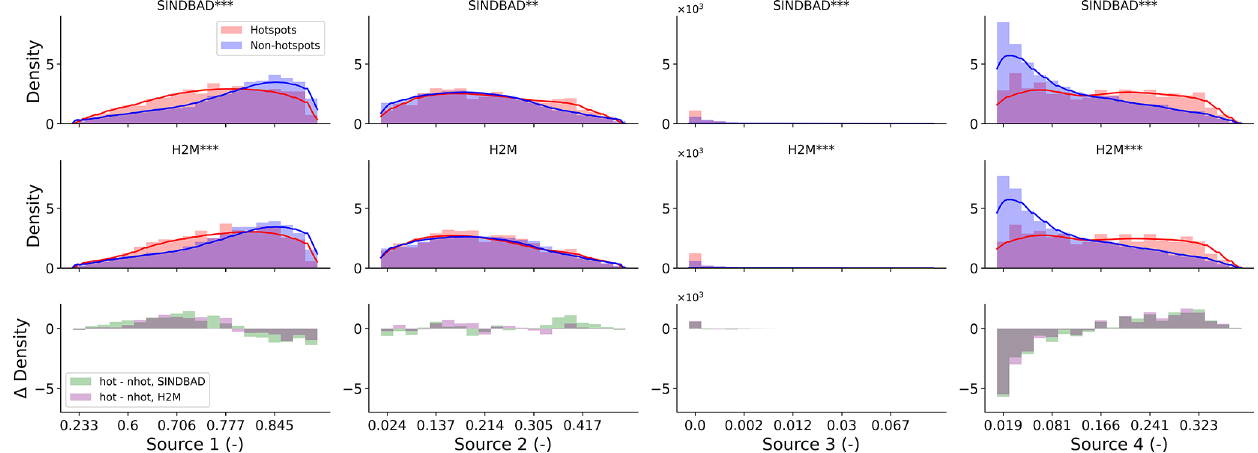
Figure B23. Same as Fig. 8 but using MSWEP instead of GPCP1dd for the precipitation forcing.